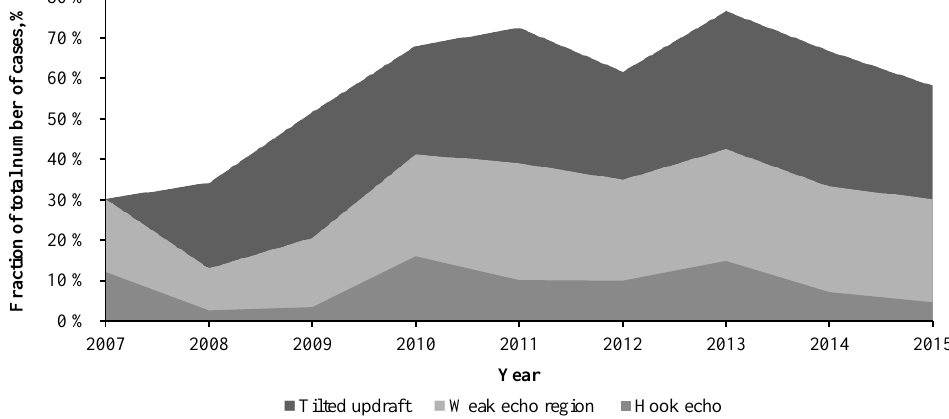
Fig. 5. The fraction of cases (%) with characteristic thunderstorm features identified from weather radar observations on days with more than 10 lightning flashes detected in Latvia over the period